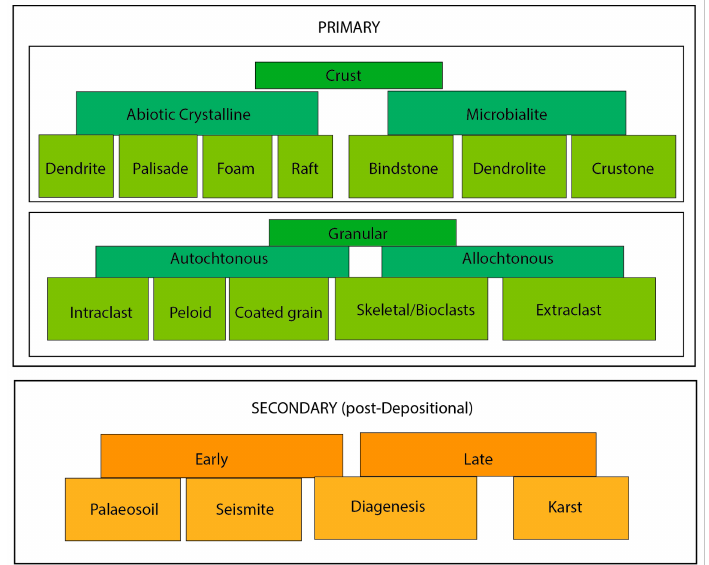
Figure 10. Diagram representing the main travertine facies associated with fissure ridges. See the text for their description.